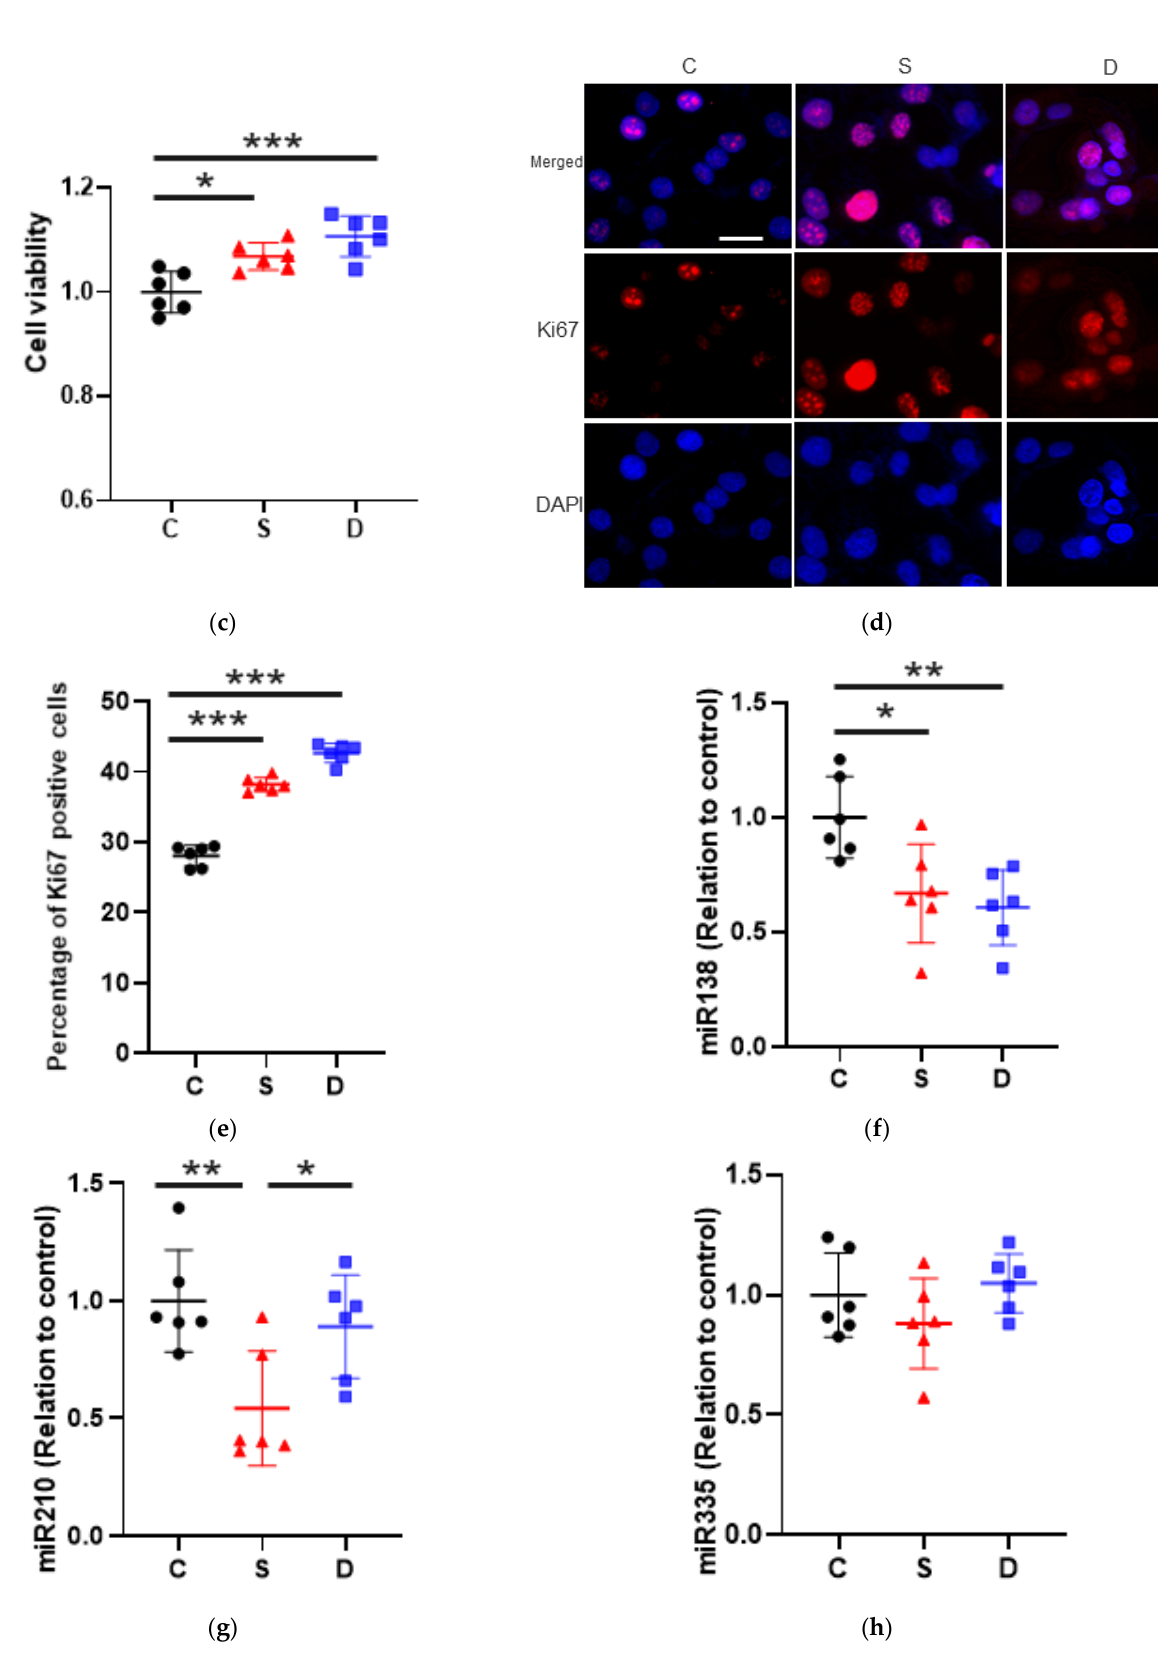
Figure 1. The changes of cell viability and miRNAs after inhalational anaesthesia. ( a ) SKOV3 cell migration analysis with wound healing assay after 2 h of inhalational anaesthesia: control (left), 3.6% sevoflurane (middle) and 10.4% desflurane (right), at 0 h later (upper), 24 h later (middle) and 48 h later (bottom). The microscopic images at 0, 24 and 48 h after general anaesthesia. ( b ) The comparison between anaesthetics in percentage of gap closure by wound healing assay. ( c )